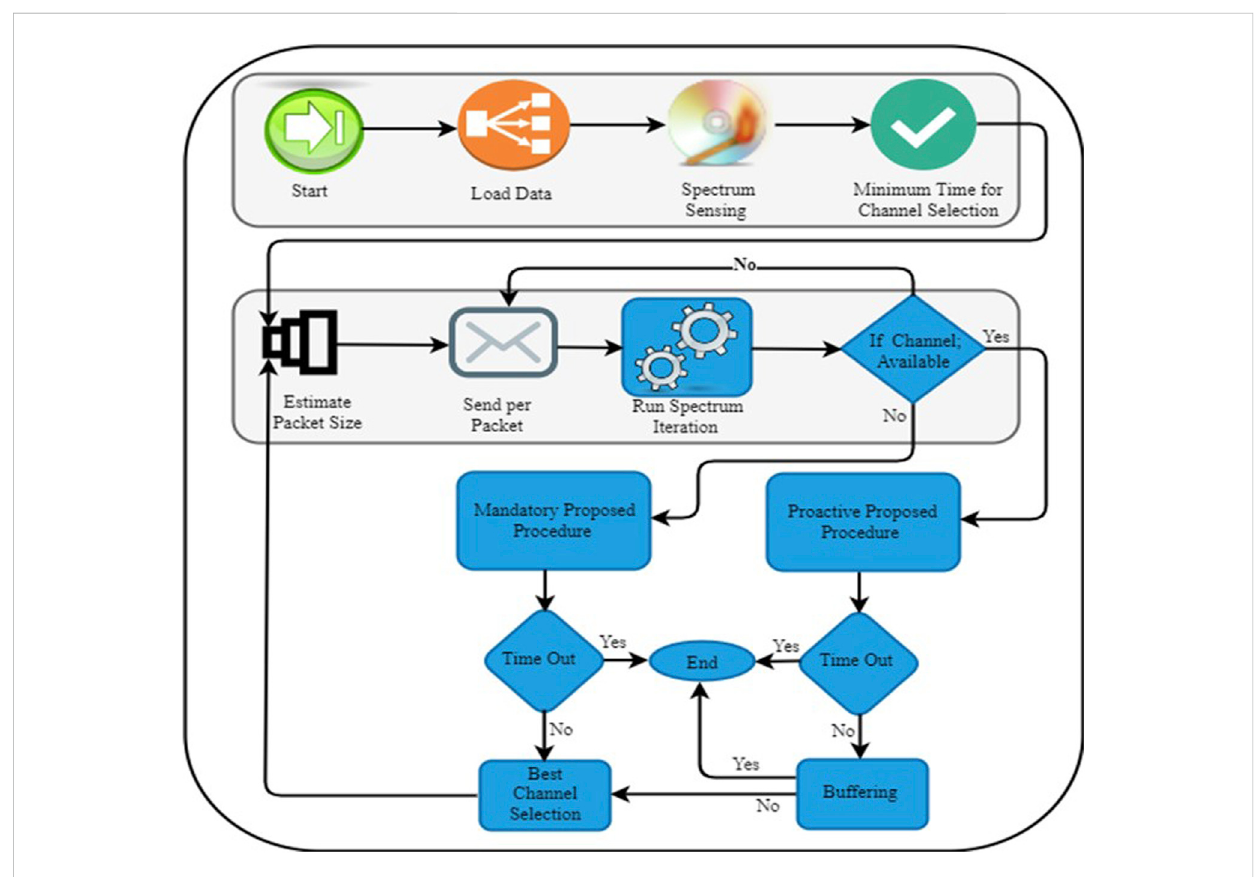
FIGURE 1 Proposed architecture for delay-sensitive image transmission in cognitive radio